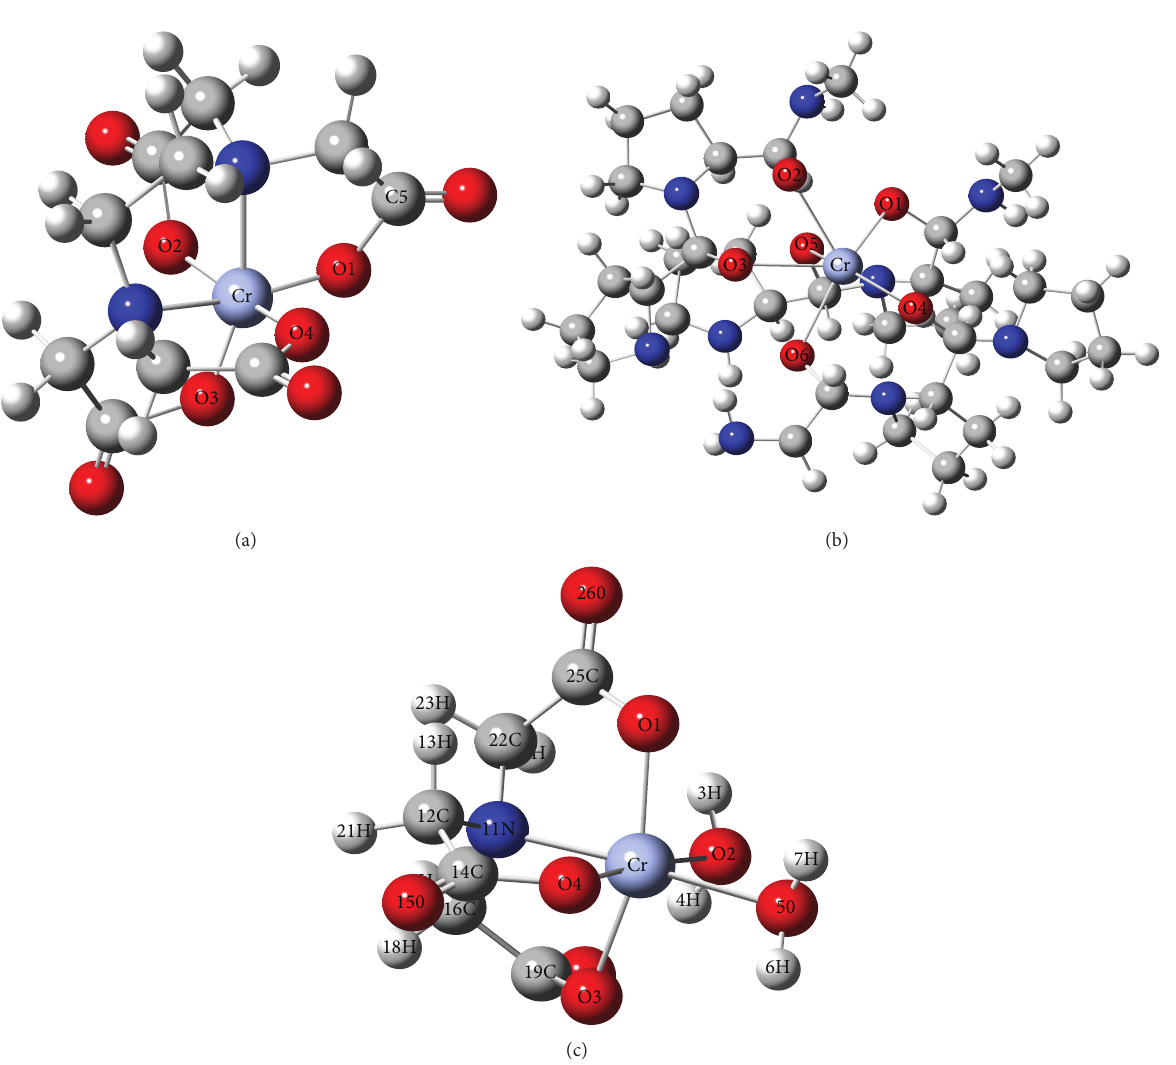
electronic density at BCP (𝜌) , the Laplacian of the electron density (∇ 2 𝜌) , the potential energy (Vc), kinetic energy (Gc), and the total electron energy (Hc), are useful for detect- ing and characterizing the chemical bonds such as